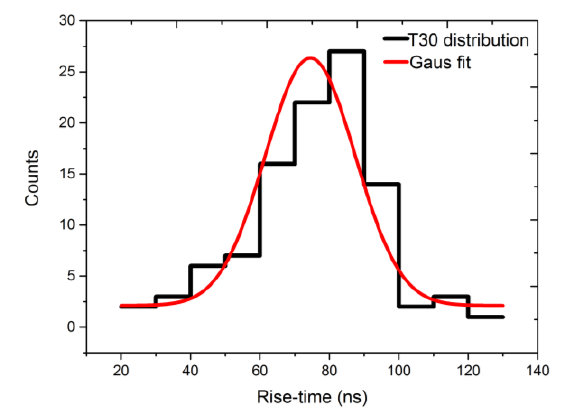
Fig. 5: Plot of counts vs rise-time (T30) at a specific depth. The red curve is the Gaussian fit (used to find centroid of the distribution). The analysis has been extended to find the rise-time as a function of depth for both the DC4 and AC20 electrodes. It is shown in Fig. 6(a)-(b).